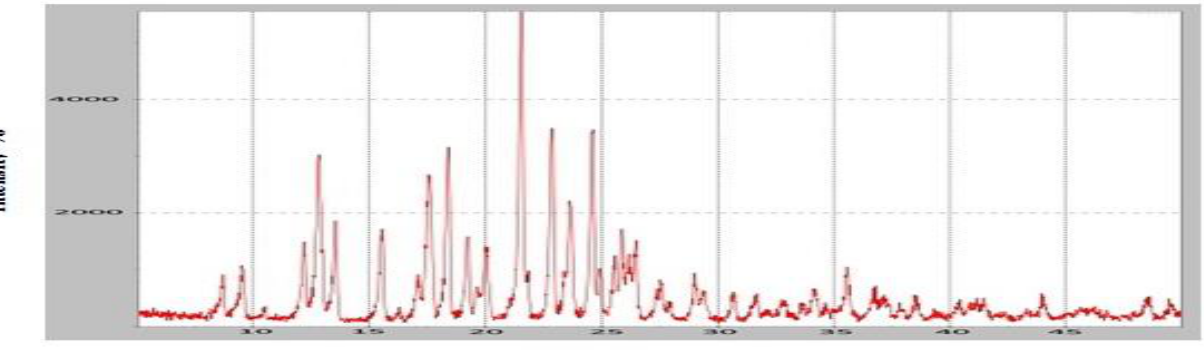
Figure 9. X-Ray diffraction of pure clopidogrel